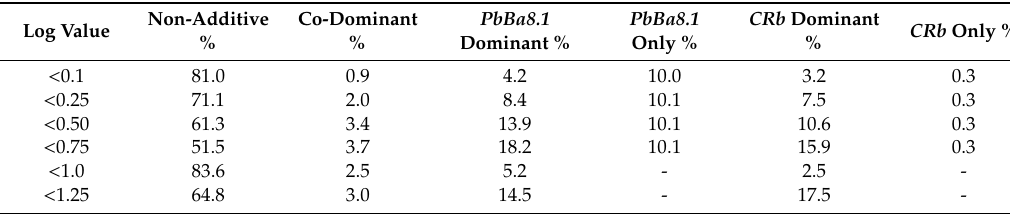
Table 1. Comparative gene expression analysis of 618R with 305R and 409R in response to different log change values after P. brassicae inoculation.